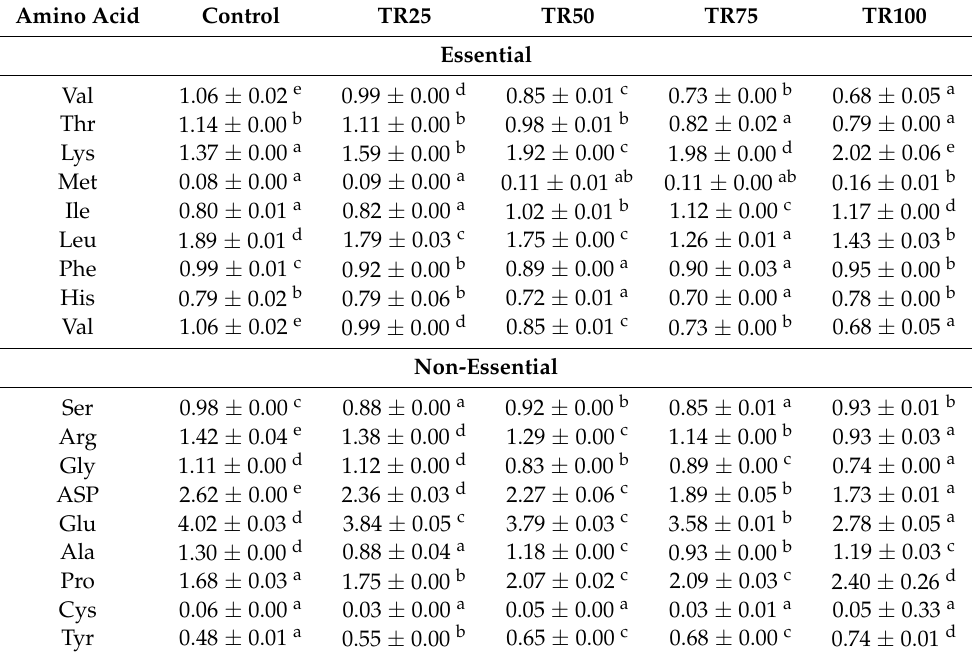
Table 6. Free amino acids (expressed as mg/100 g of sausage) profile of sausages with pork fat replaced by